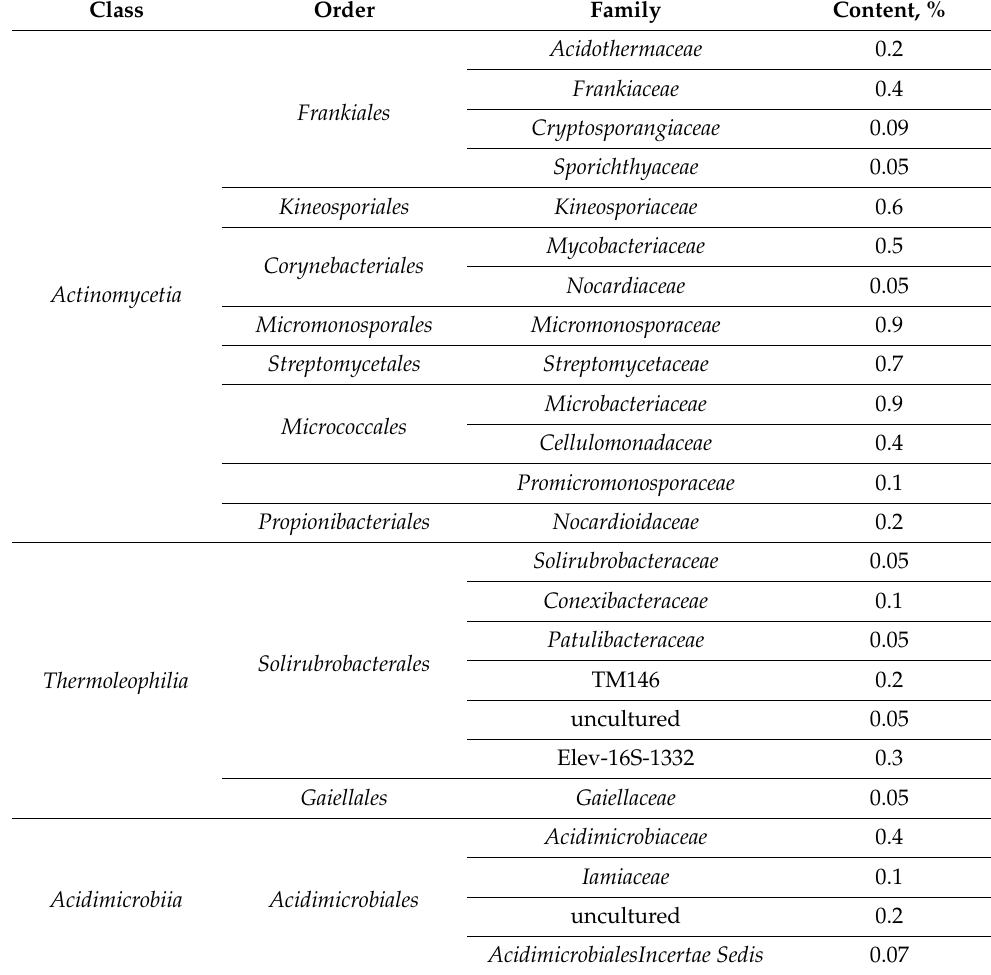
Table 5. Representation of taxa of the phylum Actinobacteriota in plant litter.